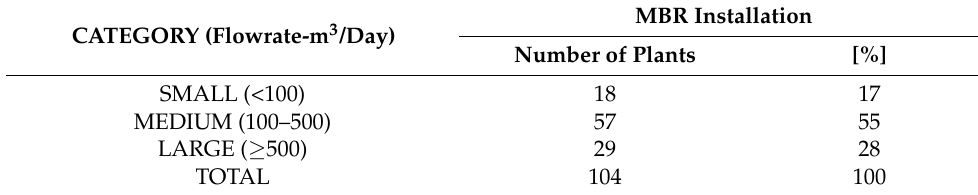
Table 2. Italian MBR plants treating industrial wastewater.